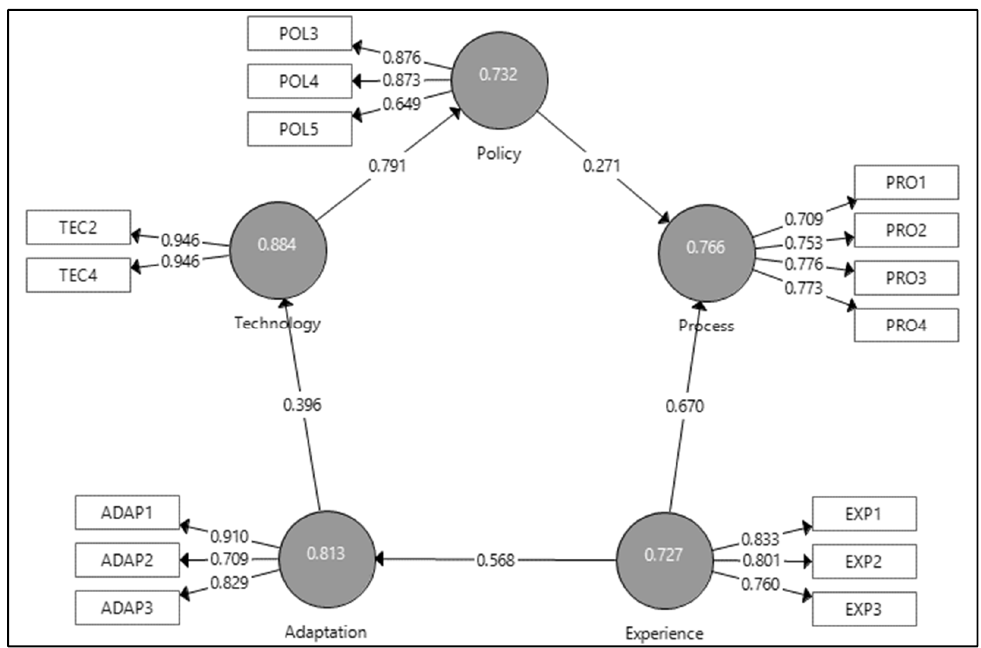
Figure 5. Proposed model for the characterization of BIM users. Table 6. Discriminant reliability according to the criterium of Fornell and